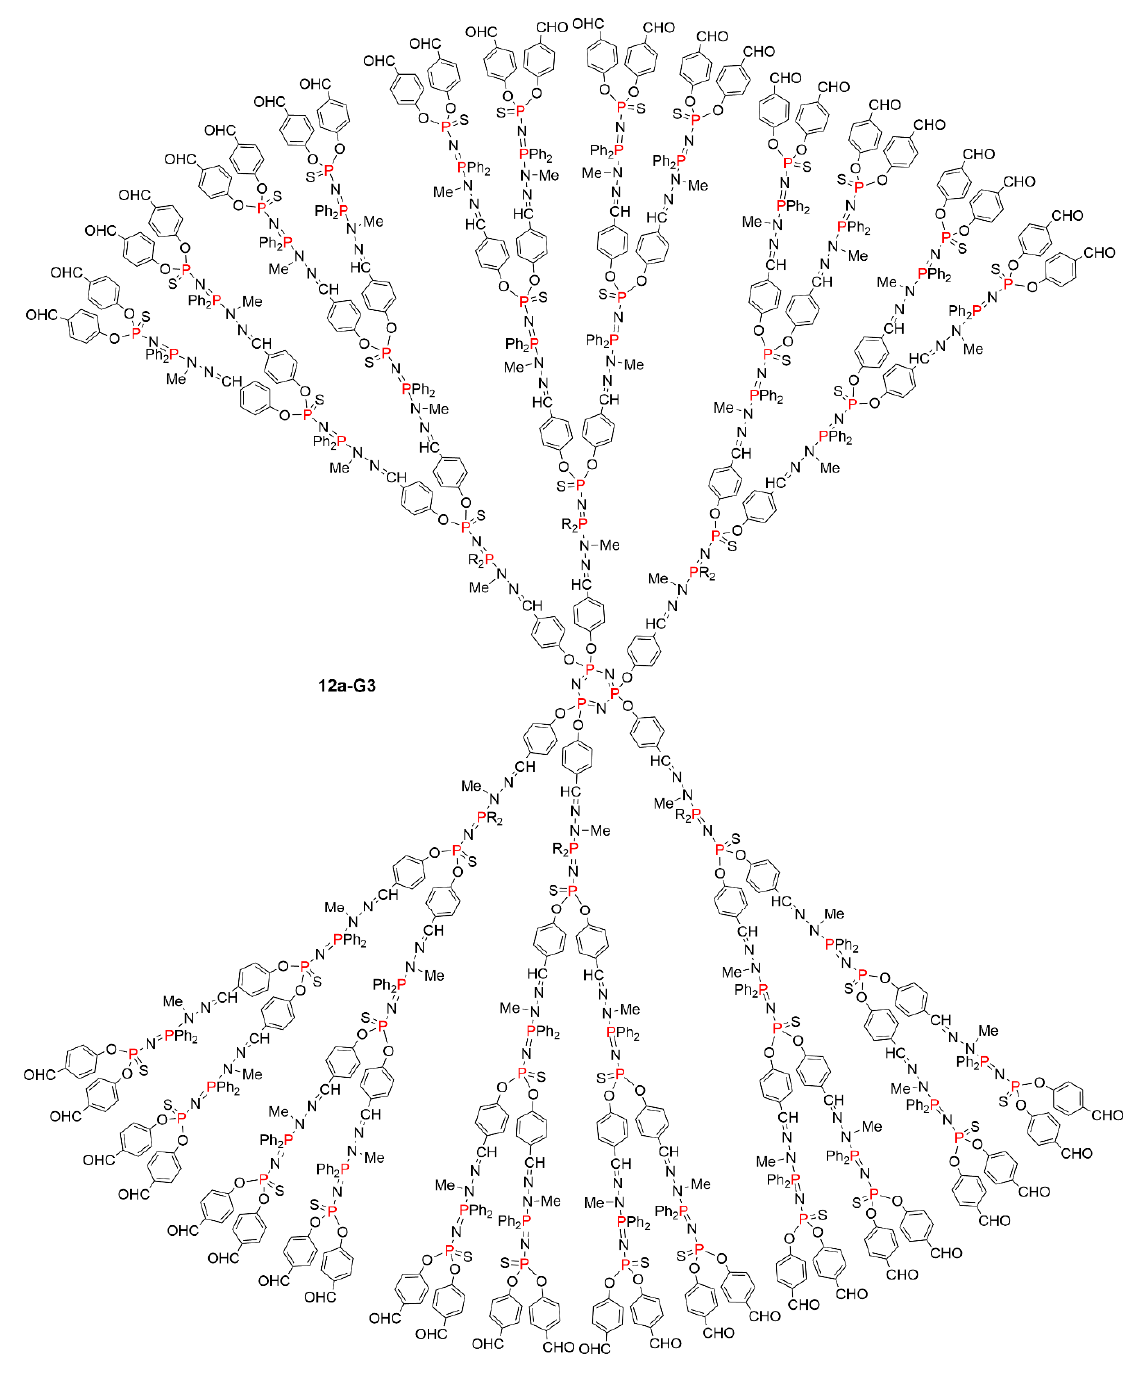
Figure 7. Full chemical structure of the dendrimer 12a-G3 , the linear form of which is shown in Scheme 12.